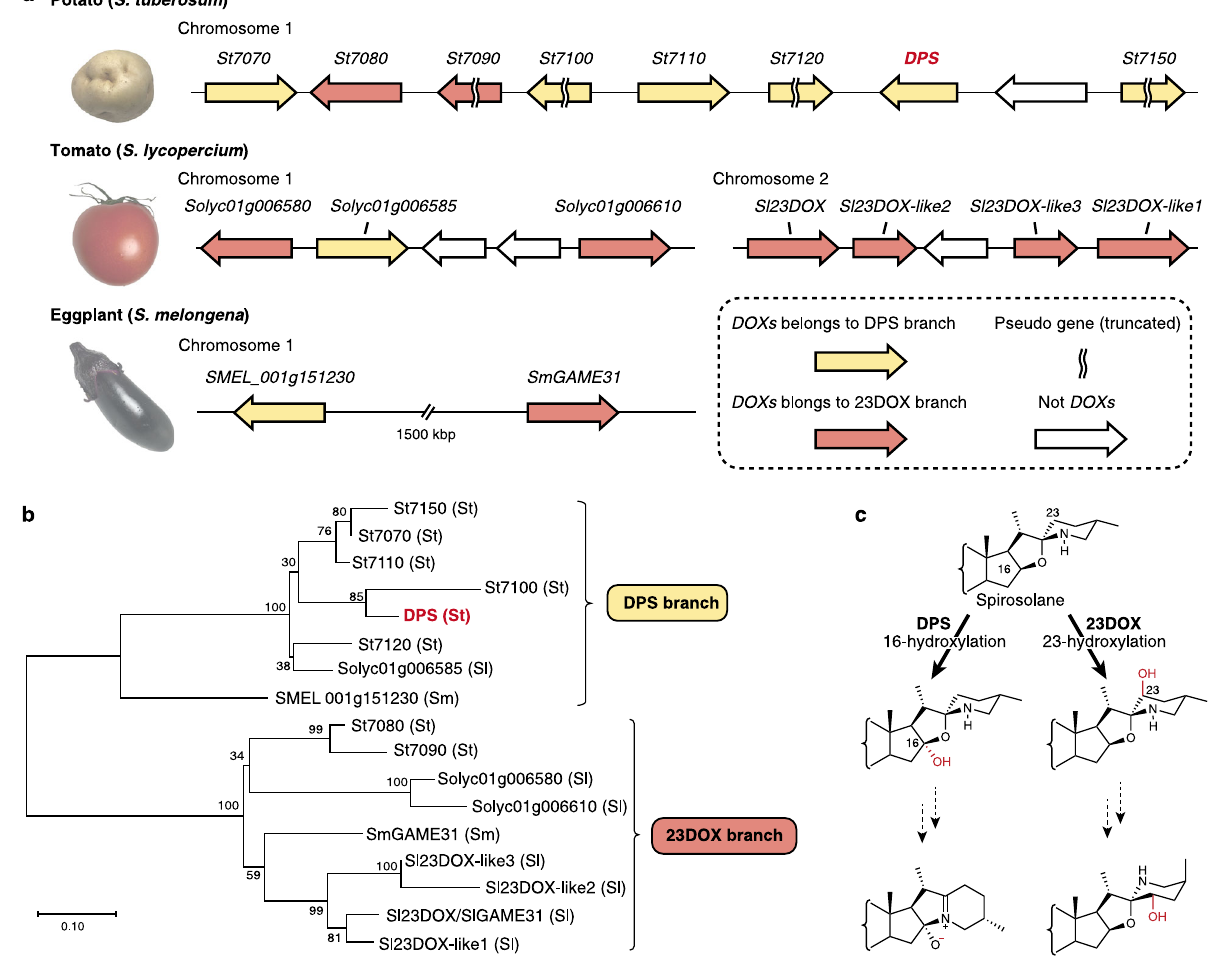
Fig. 5 Evolution of the DPS homologous genes associated with SGA metabolism in Solanum plants. a Genomic organization of the DPS homologous genes in potato, tomato, and eggplant. Genes belonging to the DPS branch and genes belonging to the 23DOX branch in phylogenetic analysis are shown in yellow arrows and red arrows, respectively. White arrows indicate genes not belonging to the DOX superfamily. b Phylogenetic analysis of the DPS homologous genes. A phylogenetic tree was generated using the maximum-likelihood method in MEGA X. Bootstrap values based on 1000 replicates are shown at the branching points. St S. tuberosum (potato), Sl S. lycopersicum (tomato), Sm S. melongena (eggplant). c Reactions catalyzed by DPS and 23DOX. 23DOX catalyzes C-23 hydroxylation of α -tomatine, and the product spontaneously isomerizes to neorickiioside B, which is an intermediate in α -tomatine metabolism that appears during ripening. Photos of tomato, potato, and eggplant were taken by Ryota Akiyama, Graduate School of Agricultural Science, Kobe